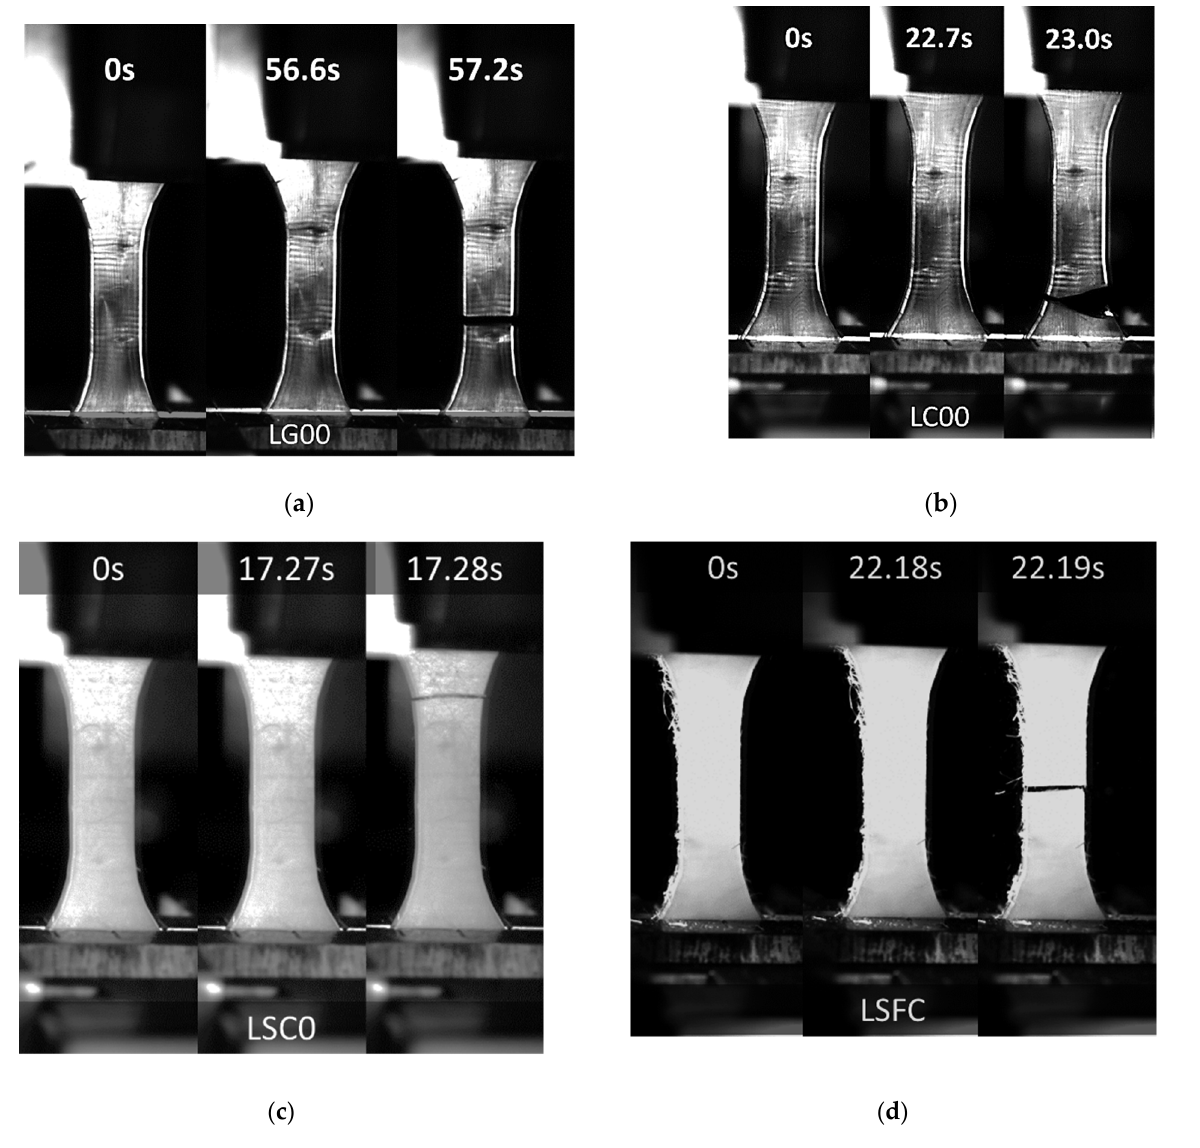
Figure 7. Deformation sequence of studied composites captured at different times: ( a ) LG00 ( b )